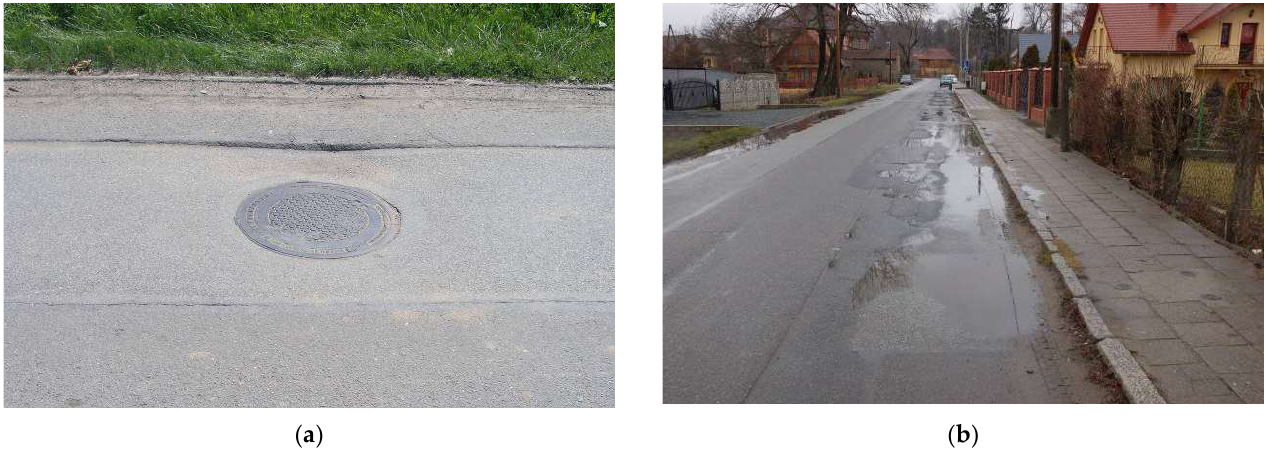
Figure 4. Examples of the roadway damage: ( a ) a collapsed well, ( b ) asphalt defects filled with water.